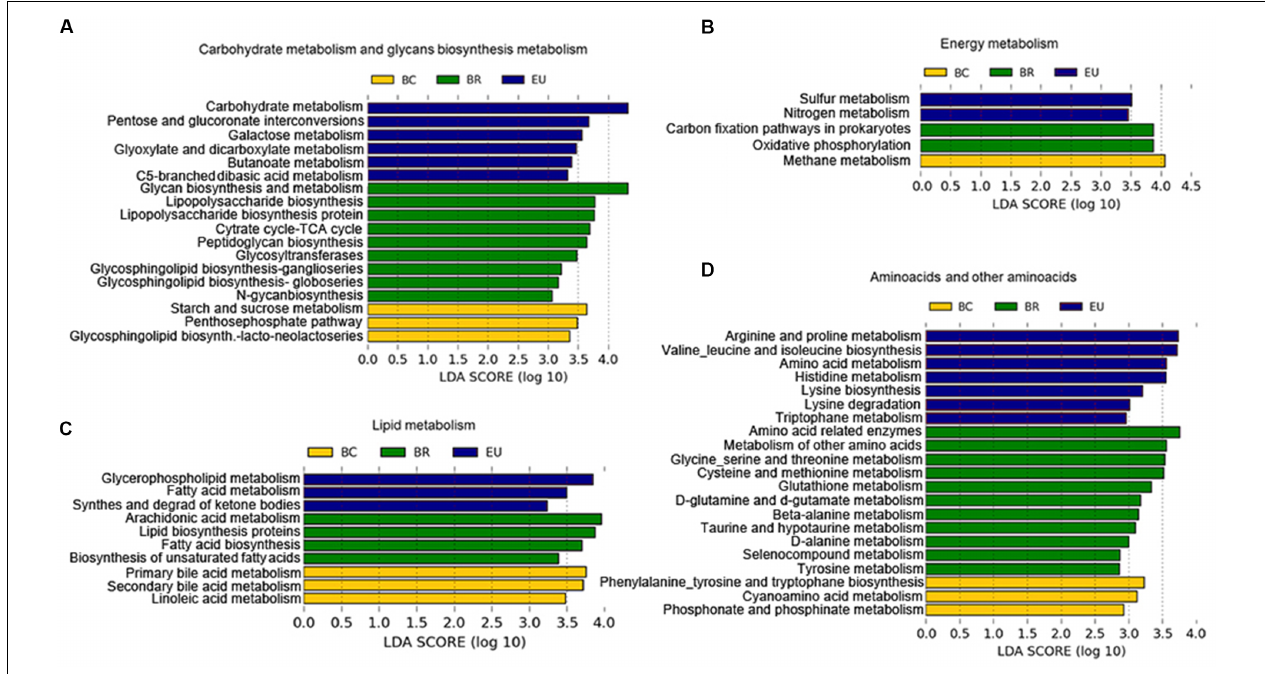
FIGURE 7 | Differences in the most representative bacterial functional classes (KEGG categories level 3). (A–D) Functional pathways significantly enriched in African and European populations based on PICRUSt prediction. LEfSe results indicate a sequentially significant ranking among populations (Alpha value = 0.05 for the factorial Kruskal–Wallis test among classes). The threshold for the logarithmic LDA score was